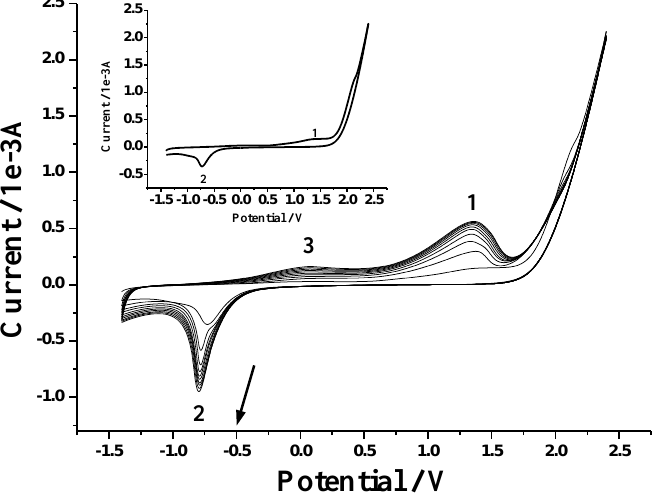
Figure 2. Repetitive cyclic voltammograms of 1.0  10 −4 M 4-ABA at MWNTs/GCE. The insert is the first cycle of the cyclic voltammogram. Scan rate: 100 mV s −1 ; supporting electrolyte: 0.10 M PBS (pH